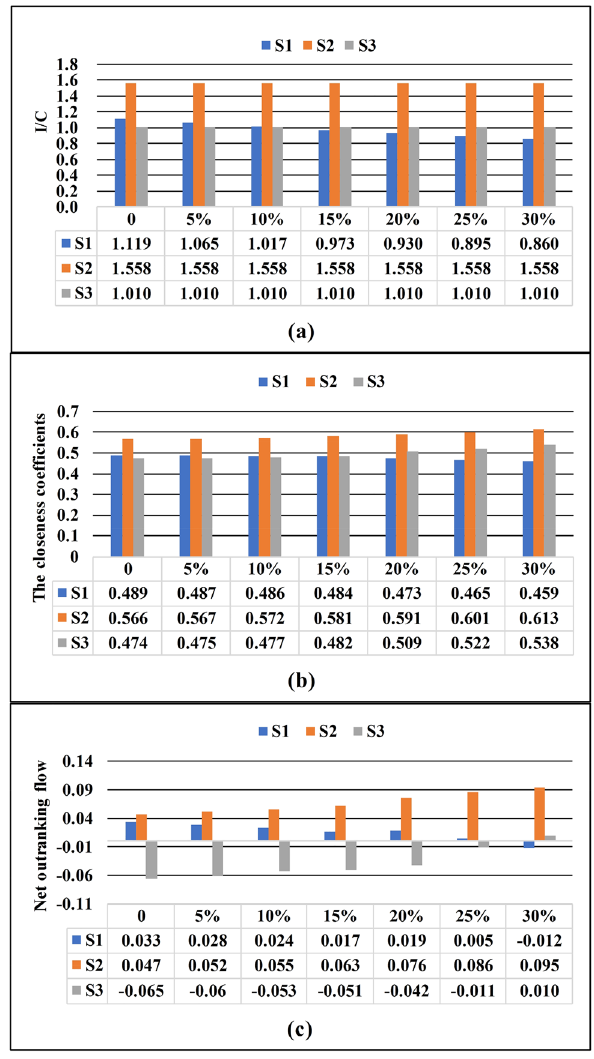
Figure 6. The final results for case 1 using the ( a ) CBA, ( b ) TOPSIS, and ( c ) PROMETHEE